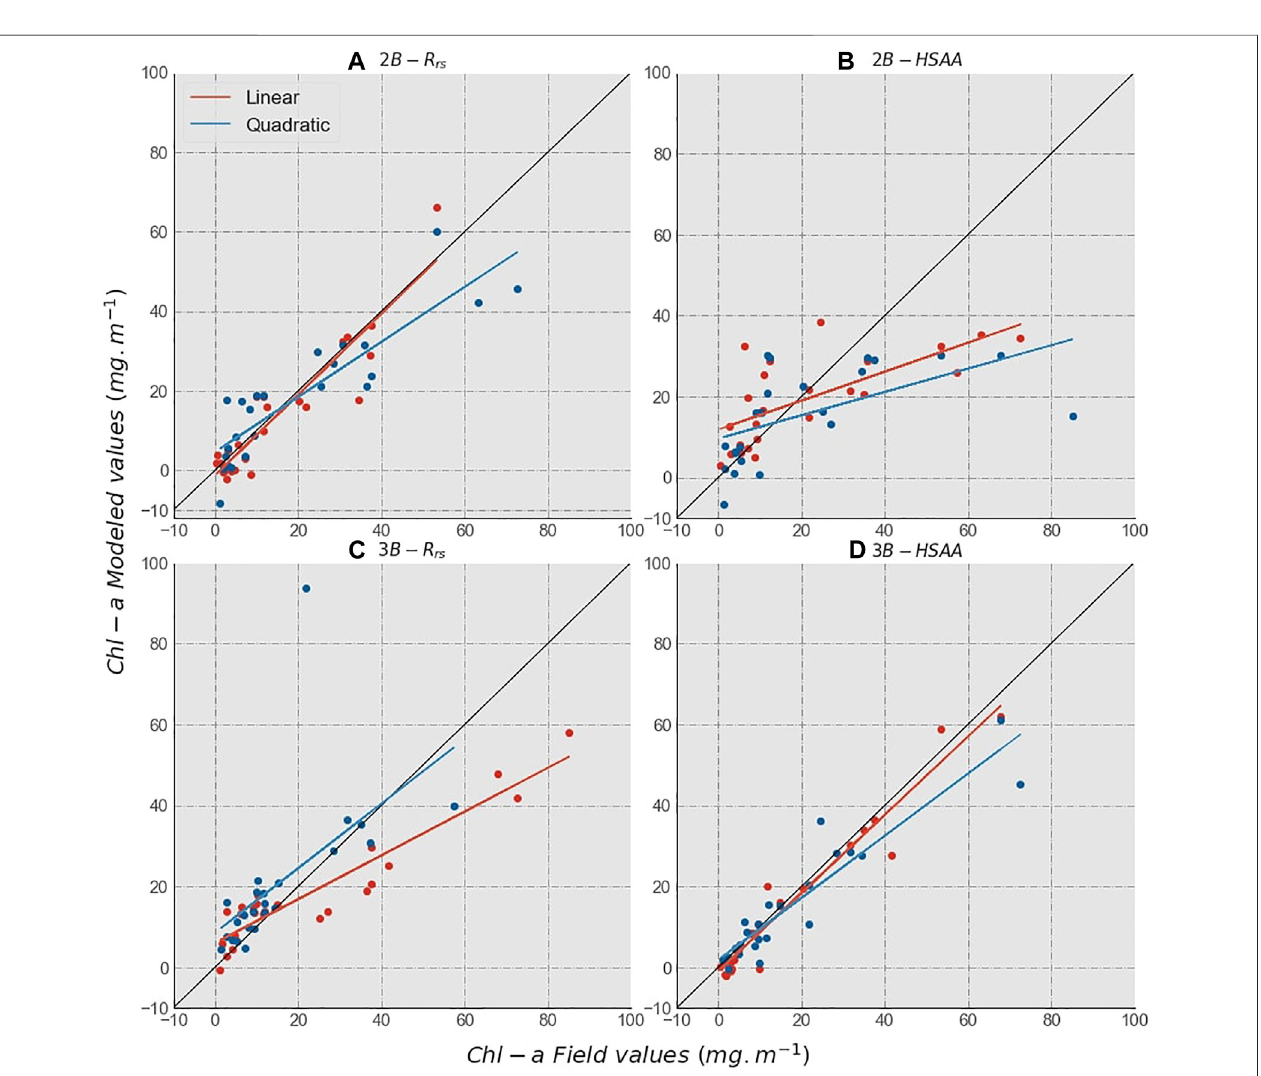
FIGURE 7 | Scatterplot between fi eld-measured Chl-a and estimated Chl-a with ( fi rst row) 2B algorithm using (A) R rs ( λ ) sim and (B) HSAA; and (second row) 3B algorithmusing (C) R rs ( λ ) sim and (D) andHSAA.Reddatarefertothemodeldevelopedusinglinear fi t,whilebluedatarefertothealgorithmdeveloped usingquadratic fi t. Note that the data in each plot correspond to the validation dataset that is closer to the mode of MAPE values and may not be the same in all plots.